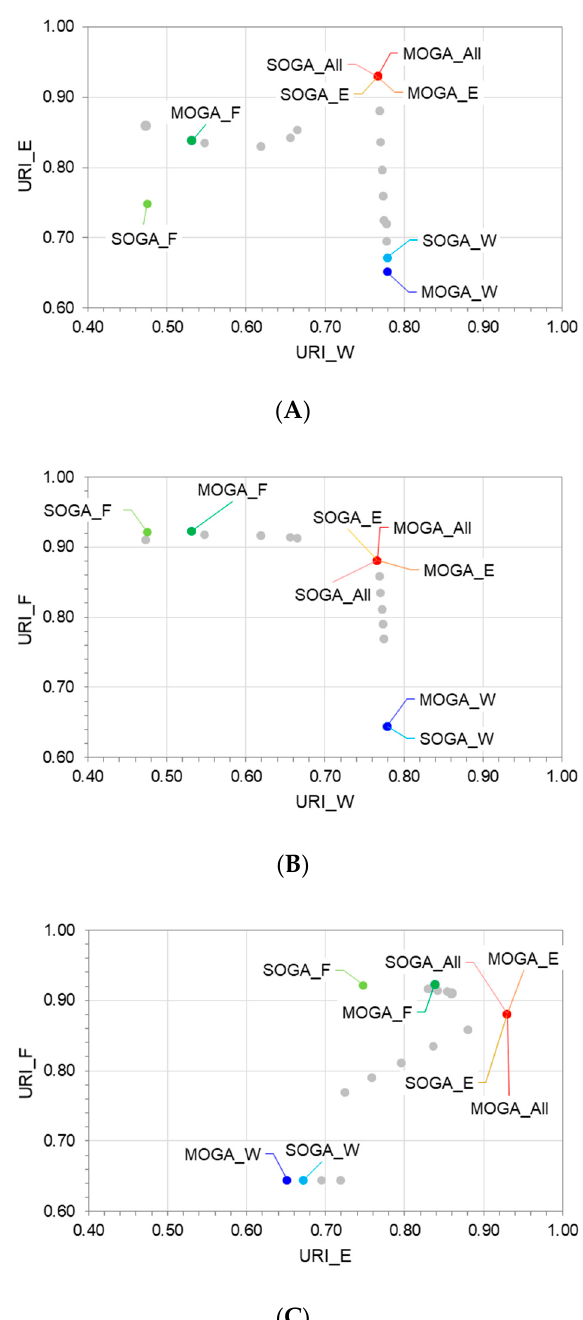
Figure 5. Maximum user reliability indices (URIs) obtained from single-objective genetic algorithm (SOGA) and multi-objective genetic algorithm (MOGA) for ( A ) water–energy, ( B ) water–food, and ( C ) energy–food pairs.